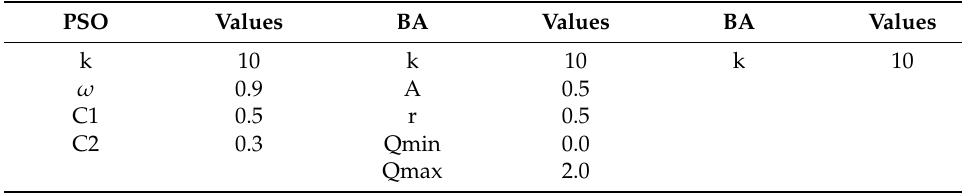
Table 1. Parameter set for SI